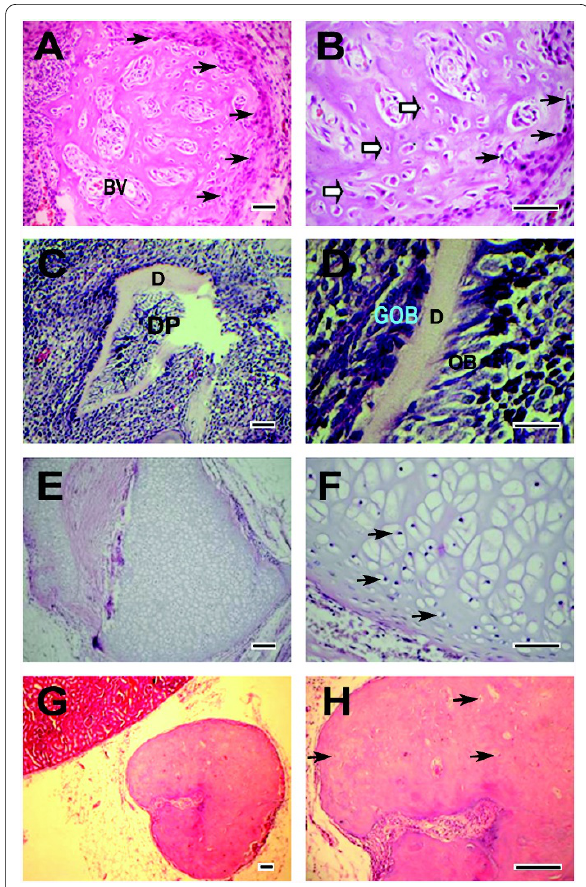
Figure 5 In vivo transplantation results of DPSC pellets at differ- ent passages (hematoxylin and eosin staining) . ( A ) DPSC-P1 pellets generated bone tissues surrounded by osteoblasts (black arrows) at day 14, in which blood vessel-like structure (BV) can be observed. ( B ) A higher magnification of ( A ). Distinct osteocyte lacunae (open arrows) containing osteocytes were observed inside the bone structure and many osteoblasts (black arrows) located around the bone tissues. ( C ) 14-day DPSC-P1 pellets developed into a dentin-pulp complex con- taining dental pulp structures (DP). ( D ) A higher magnification of ( C ). Columnar odontoblasts (OB) arrayed orderly along the inner side of dentin matrix (D). Many globular odontoblasts (GOB) located along the outer side of dentin structure. ( E ) 14-day DPSC-P1 pellets formed carti- lage tissues. ( F ) A higher magnification of ( E ). Many chondrocytes (black arrows) located inside the cartilage tissues. ( G ) All DPSC pellets at the 9 th passage bring about the formation of bone structures. No dis- tinct osteoblast appeared around the mineralization tissue. ( H ) A high- er magnification of ( G ). Osteocyte lacunae (black arrows) containing few osteocytes inside the bone tissues. Scale bars: 50